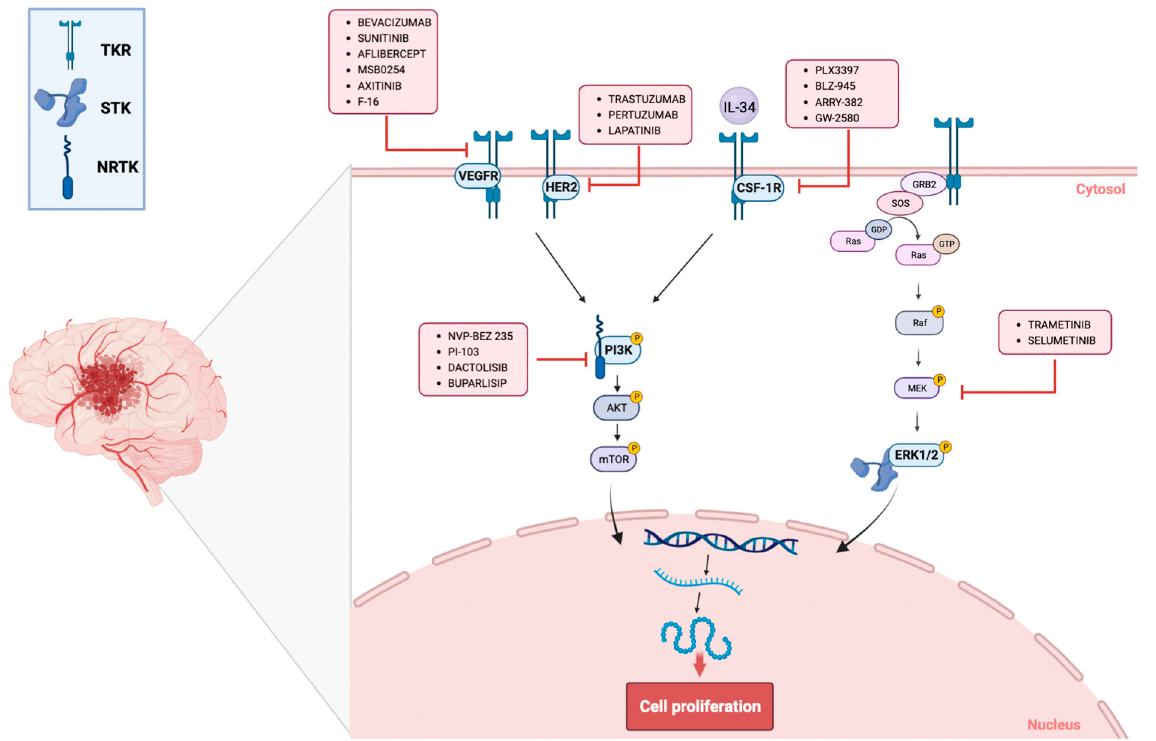
Figure 2. Effects of kinase inhibitors drugs in brain tumors. In brain tumors, inhibition of kinases such as TKR, STK, and NRTK by new molecules significantly reduced the proliferation, migration, and invasion of cancer cells in clinical and preclinical studies. The figure was created with the help of Biorender.com (accessed on 30 May 2022).